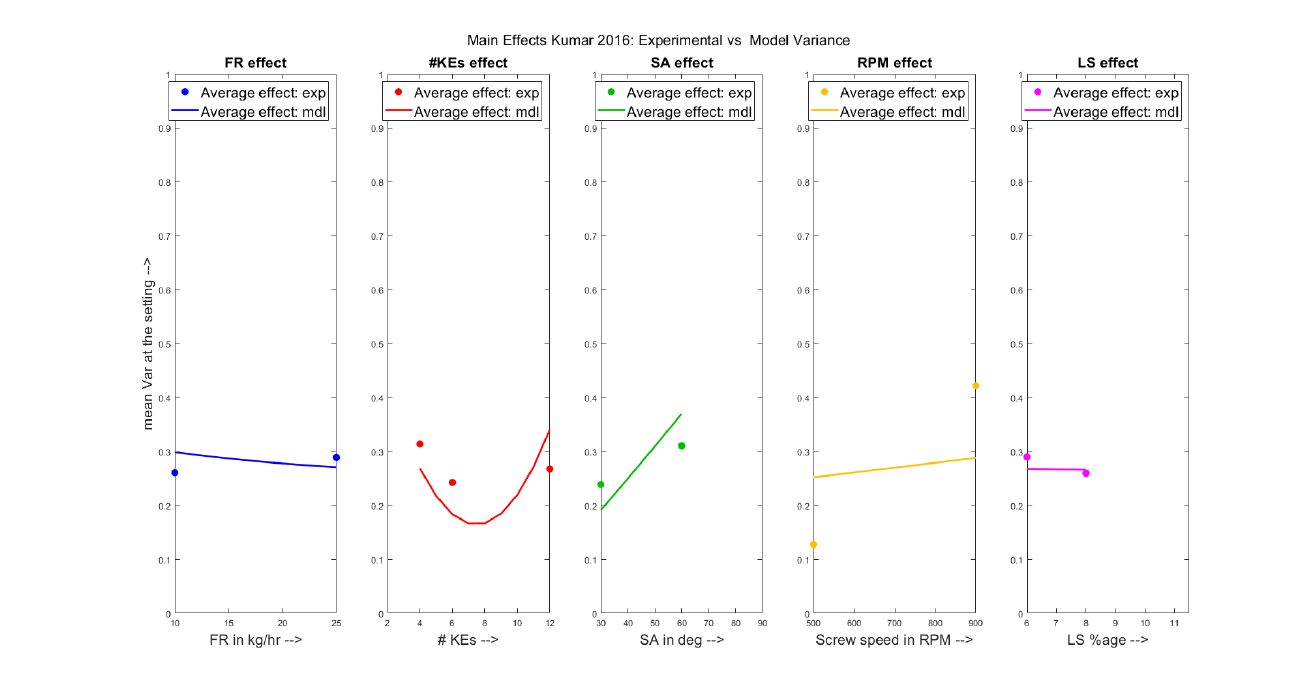
Figure 7. Experimental results vs. Model predictions: Main effects of varied parameters on variance for the Kumar et al. 2016 [26]